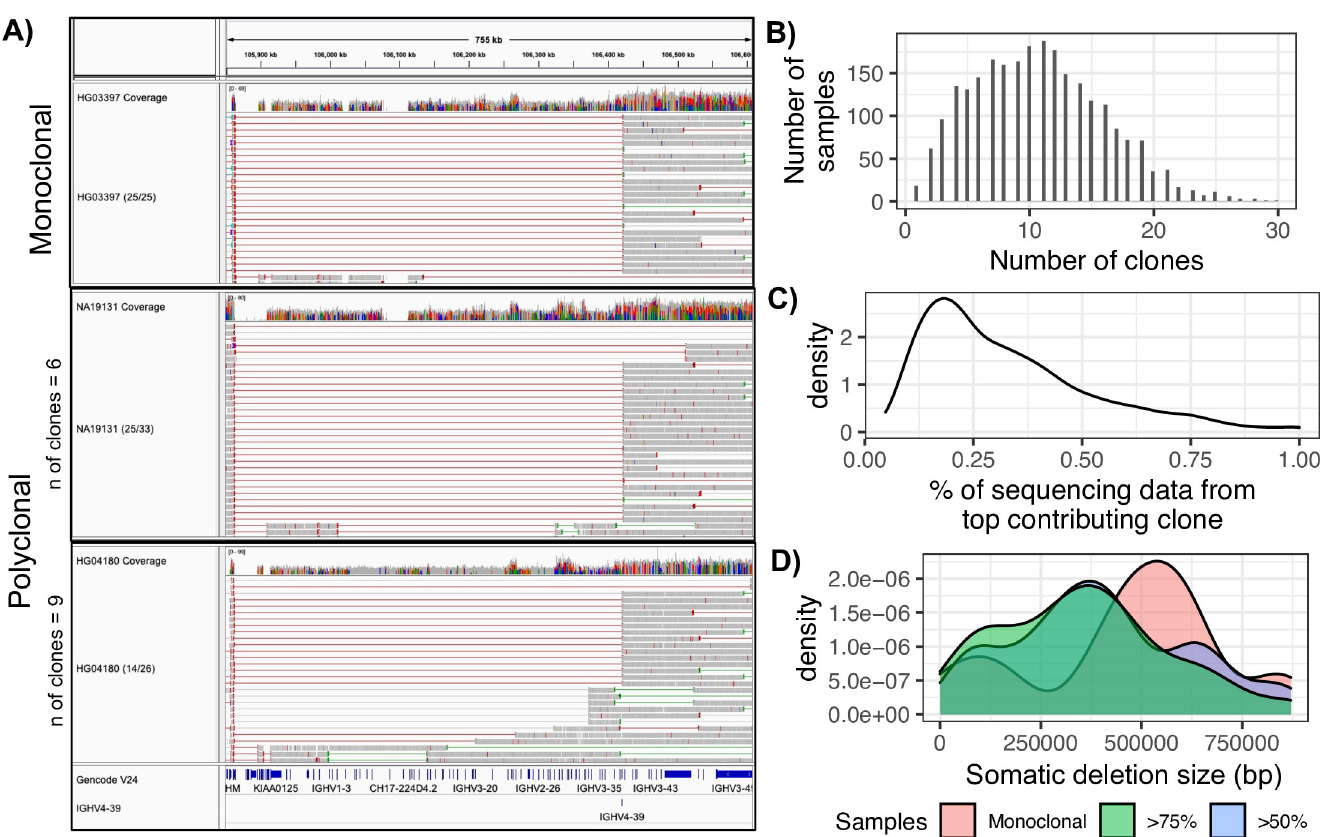
Fig 3. Data signatures of clonality in different samples. (A) IGV screenshots showing three representative samples with different degrees of clonality, all of which are represented by a dominant clone involving the V(D)J selection of IGHV4-39 . Red and gray lines represent long paired read insert lengths. HG03397 has 25 read pairs aligning to IGHV4-39 and are labelled as monoclonal. NA19131 and HG04180, which are defined as polyclonal, have 25/33 and 14/26 read pairs aligning to IGHV4- 39 . (B) The numbers of samples represented by varying numbers of identified “clones” (unique IGHJ-IGHV pairs). (C) Density plot showing the percentage of sequencing data derived from the dominant clone across all samples. (D) Density plot showing the sizes of somatic deletions associated with the dominant clone across all samples, grouped by whether they are monoclonal or polyclonal; polyclonal samples, specifically, are partitioned into those in which either > 50% or > 75% of sequencing data was represented by the dominant